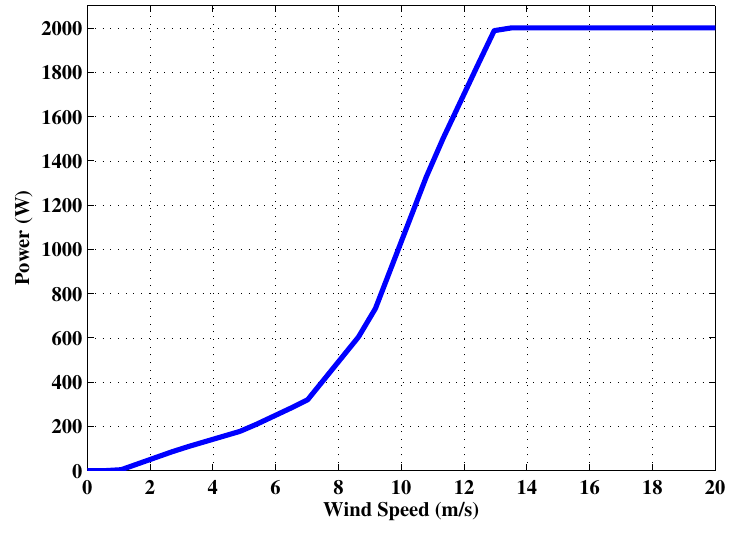
Figure 2. Power curve for a 2-kW wind